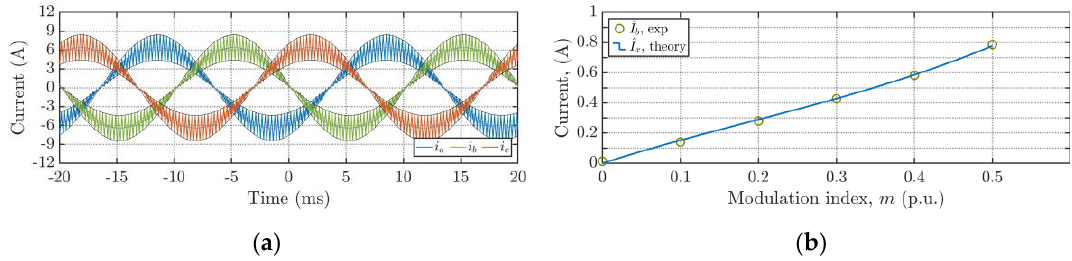
Figure 33. ( a ) Phase currents with primary (black) and secondary (gray) envelopes in case of SPWM ( m = 0.5); ( b ) Phase current ripple rms in case of SPWM.